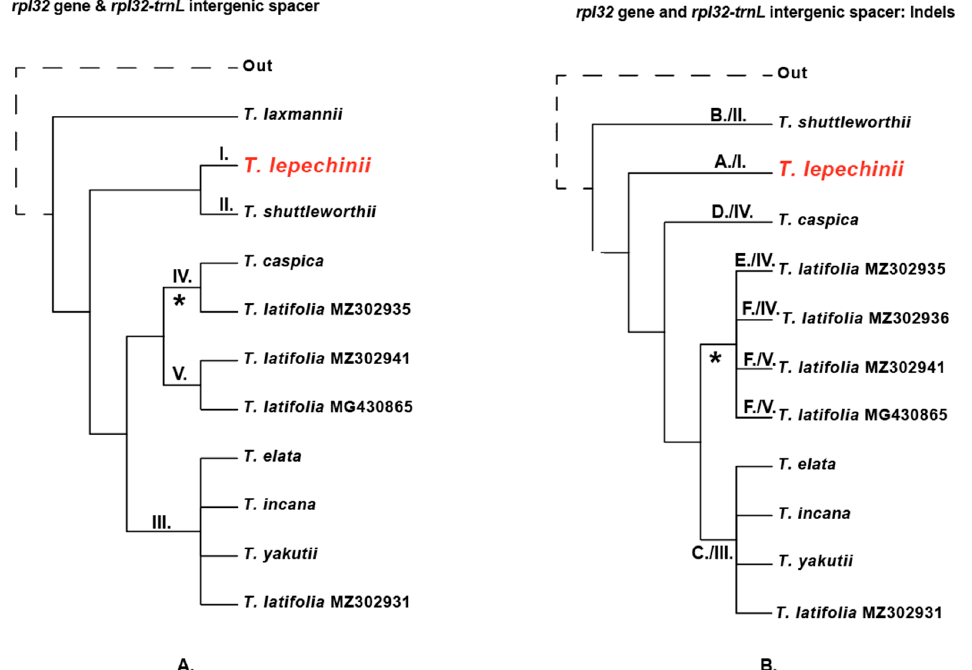
Figure 11. ( A ) The results of comparative Cladistic analysis (3TS-ACA) of five patterns of variation (I.–V.) of cpDNA ( rpl32 gene– rpl32-trnL intergenic spacer) sequence data of Typha sect. Ebracteolatae (Figure 8). The hierarchy of patterns is given as a strict consensus of 15 average consensus trees with a score of 0.17160. Fitch parsimony and 3TA yielded similar results, but with Pattern IV (indicated by an asterisk) defined as a polytomy by both analyses. ( B ) The results of comparative Cladistic analysis (3TS-ACA) of six patterns of variation of indels (A.–F.) within plastid ( rpl32 gene– rpl32-trnL intergenic spacer) sequence data matrix. The hierarchy of patterns is given as a strict consensus of 225 average consensus trees with a score of 0.41648. Wagner parsimony and 3TA yielded similar results, but with pattern IV and pattern V (indicated by an asterisk) defined as polytomy by both analyses.